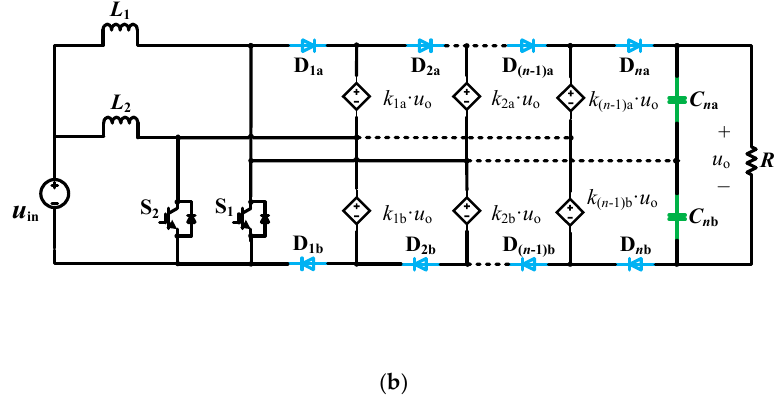
Figure 3. The topology of the VM converter: ( a ) the original circuit; ( b ) the modified circuit by replacing capacitors with controlled voltage sources.